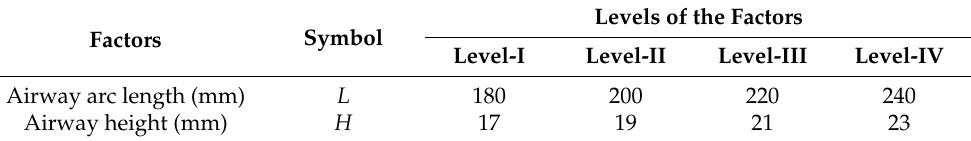
Table 1. Selection factors and levels.